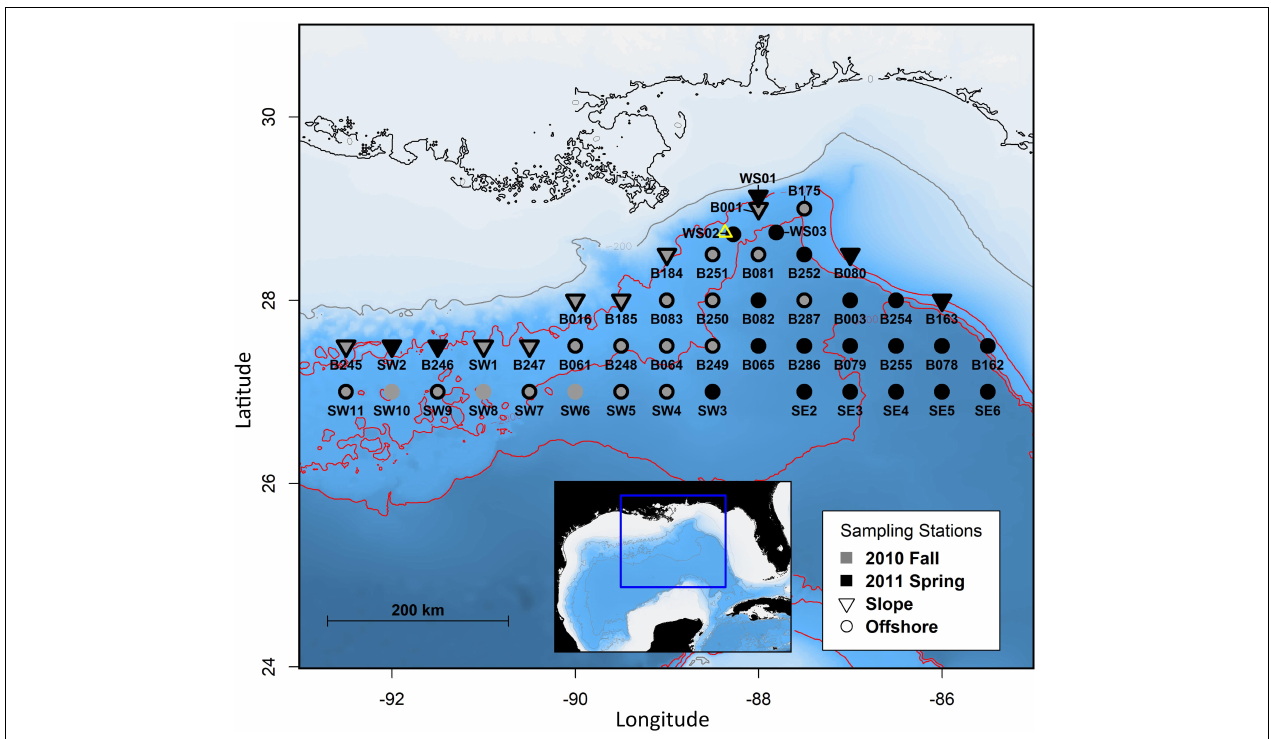
FIGURE 1 | Map of deep-pelagic plankton sampling stations in the northern Gulf of Mexico, distinguishing between sampling period (year, season) and slope vs. offshore locations. The gray line represents the 200 m isobath, red lines represent 1,000 m isobath increments, and the open yellow triangle marks the location of the Deepwater Horizon